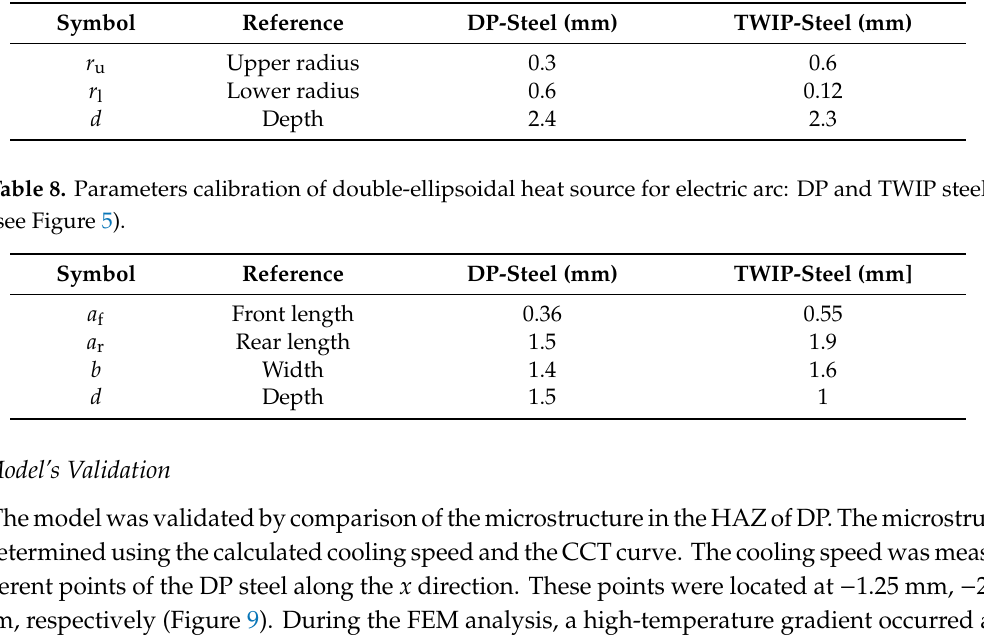
Table 7. Parameters calibration of conical heat source for laser (see Figure 4).